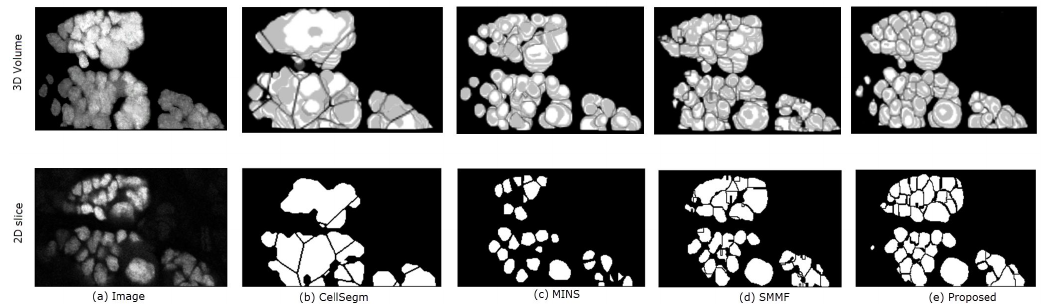
Figure 8. 3D Qualitative comparison of the 4 methods on a sample real data. The top and bottom rows show the 3D volume and a selected 2D slice respectively. Panel ( a ) shows the original data. The remaining panels are the segmentation results generated by: ( b ) CellSegm, ( c ) MINS, ( d ) SMMF, ( e ) Proposed method. While the quality indexes suggest good performance on the simulated dataset, the performance on heavily clamped nuclei is low for the CellSegm and SMMF methods. The results from MINS is unable to match the shape of individual cells compared to the proposed method. The first row shows the 3D rendered volume, while the bottom row shows a fixed slice of the volume.